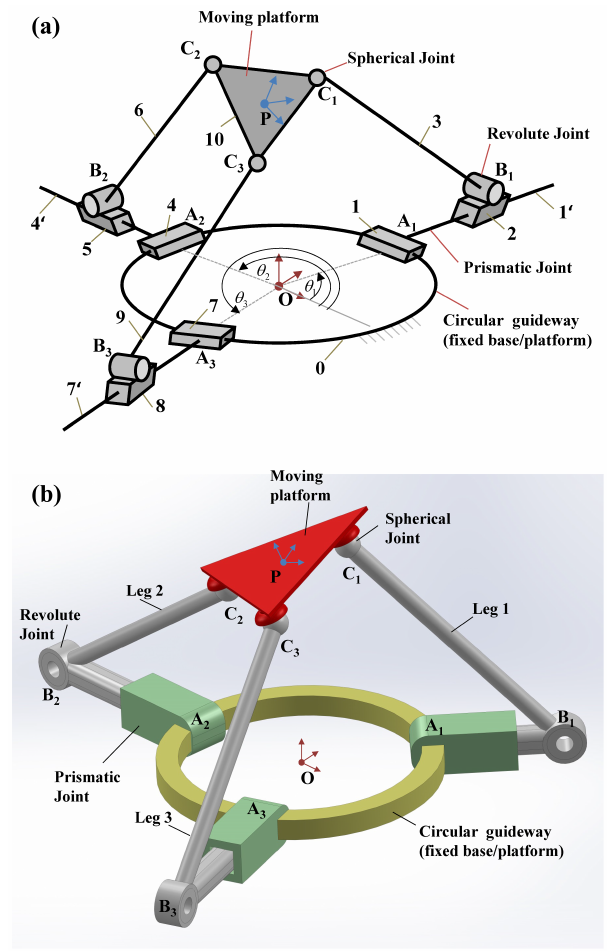
Figure 1. (a) Kinematic arrangement. (b) Solid (3-D) model of the manipulator. Conceptual design of the proposed manipulator.